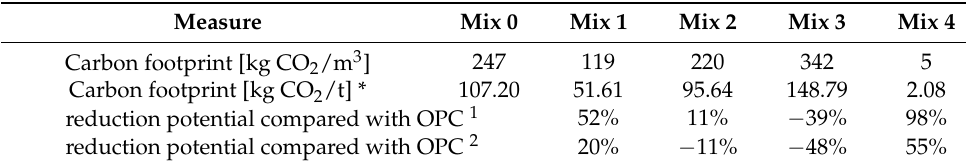
Table 5. Comparison of carbon footprints of different concrete